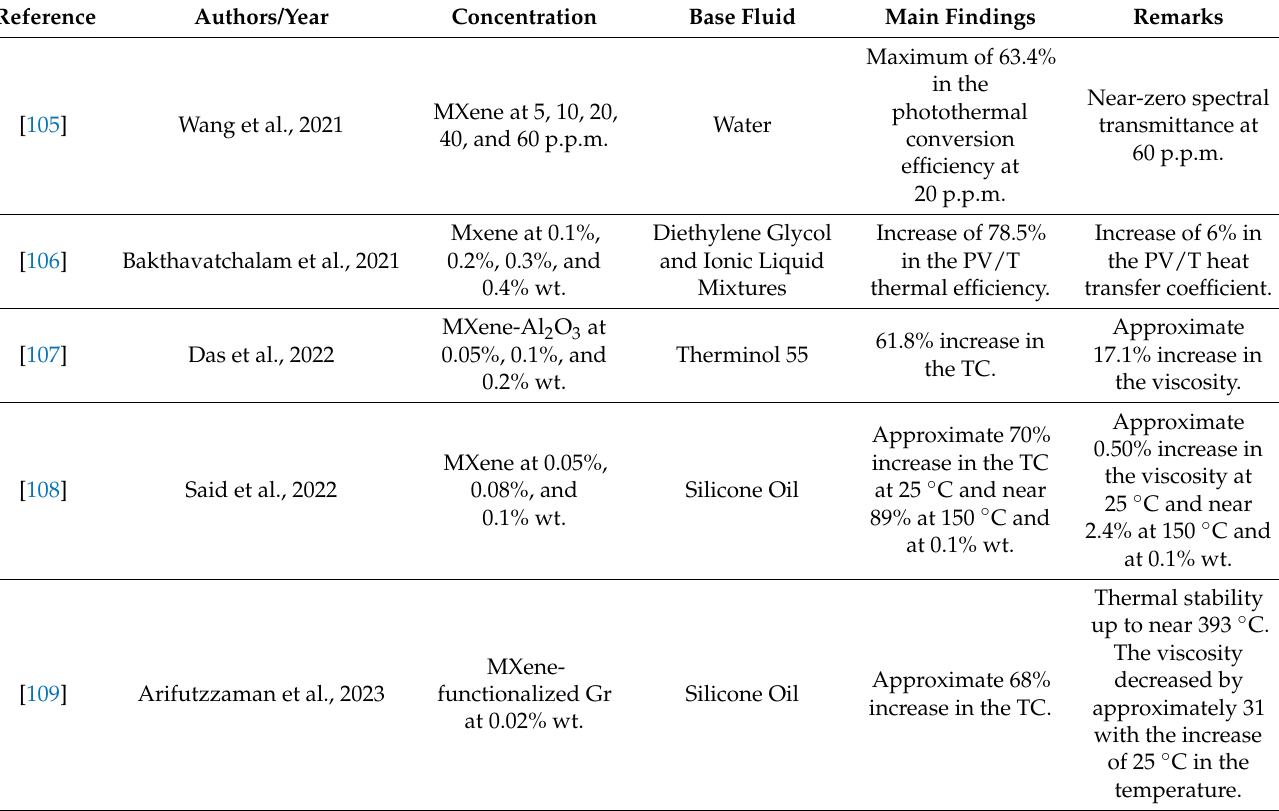
Table 5. Recent studies on 2D MXene nanofluids and